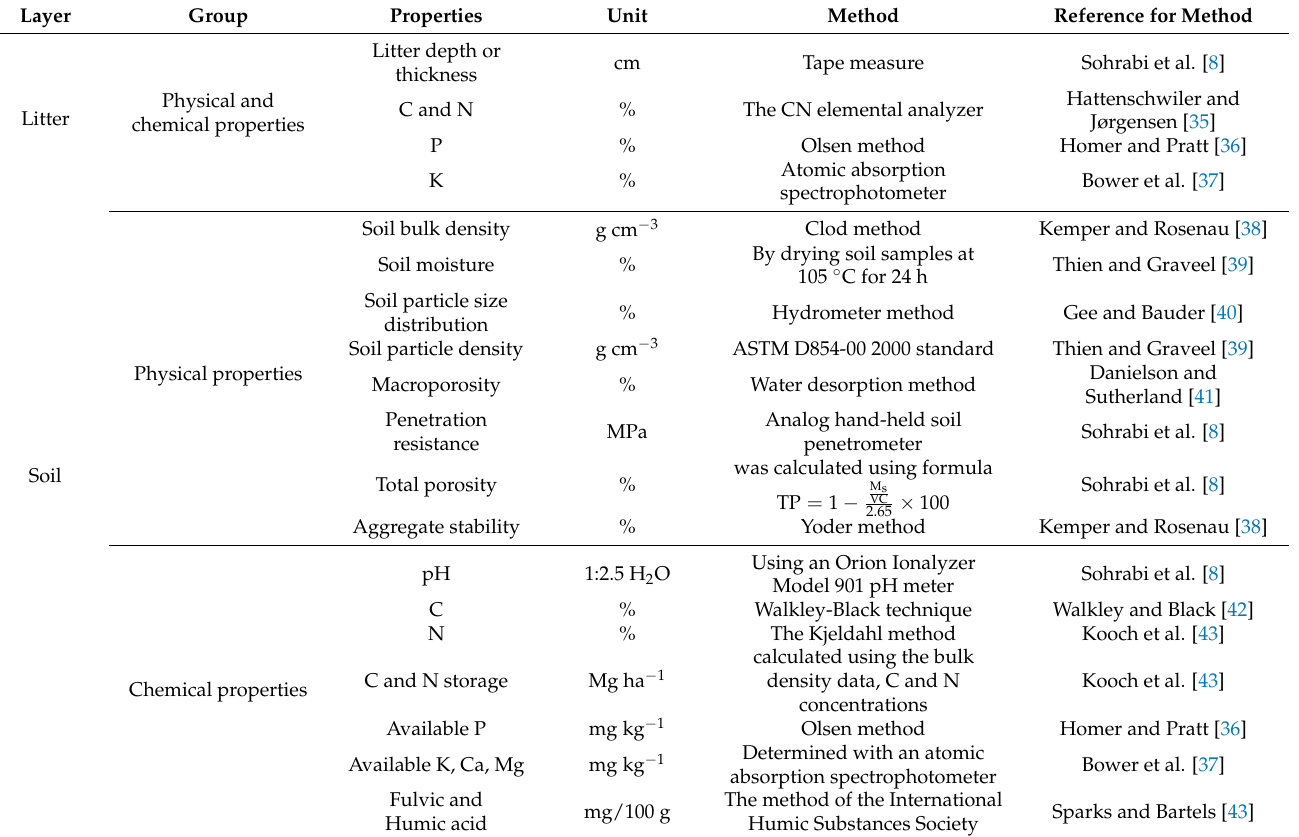
Table 2. Methods of analyzing litter and soil physio-chemical properties and